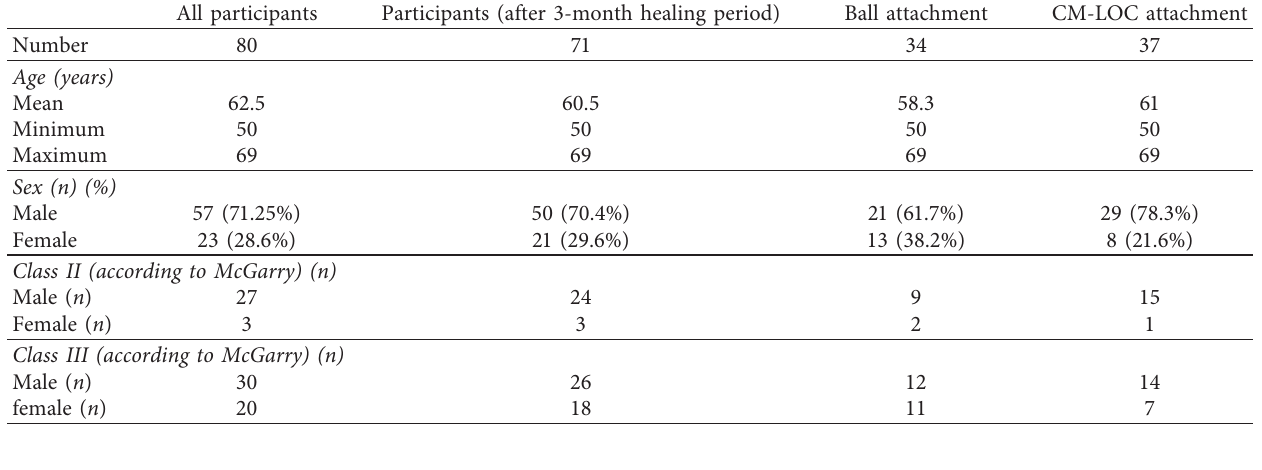
Table 1: Demographic information of all participants.